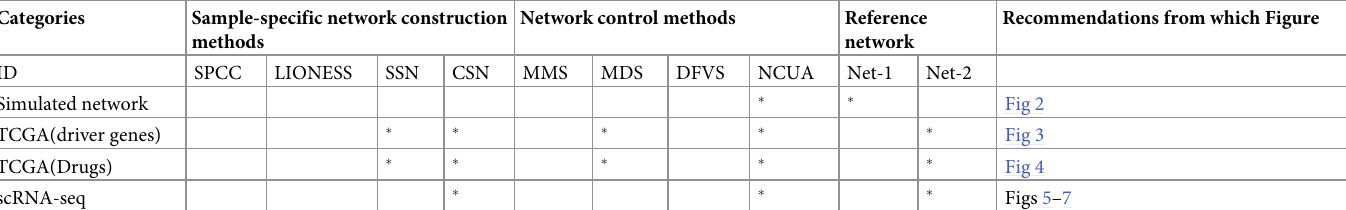
Table 1. The summary of recommended methods in different biological application scenarios. � denotes that the method is recommended in the SSC analysis. Categories